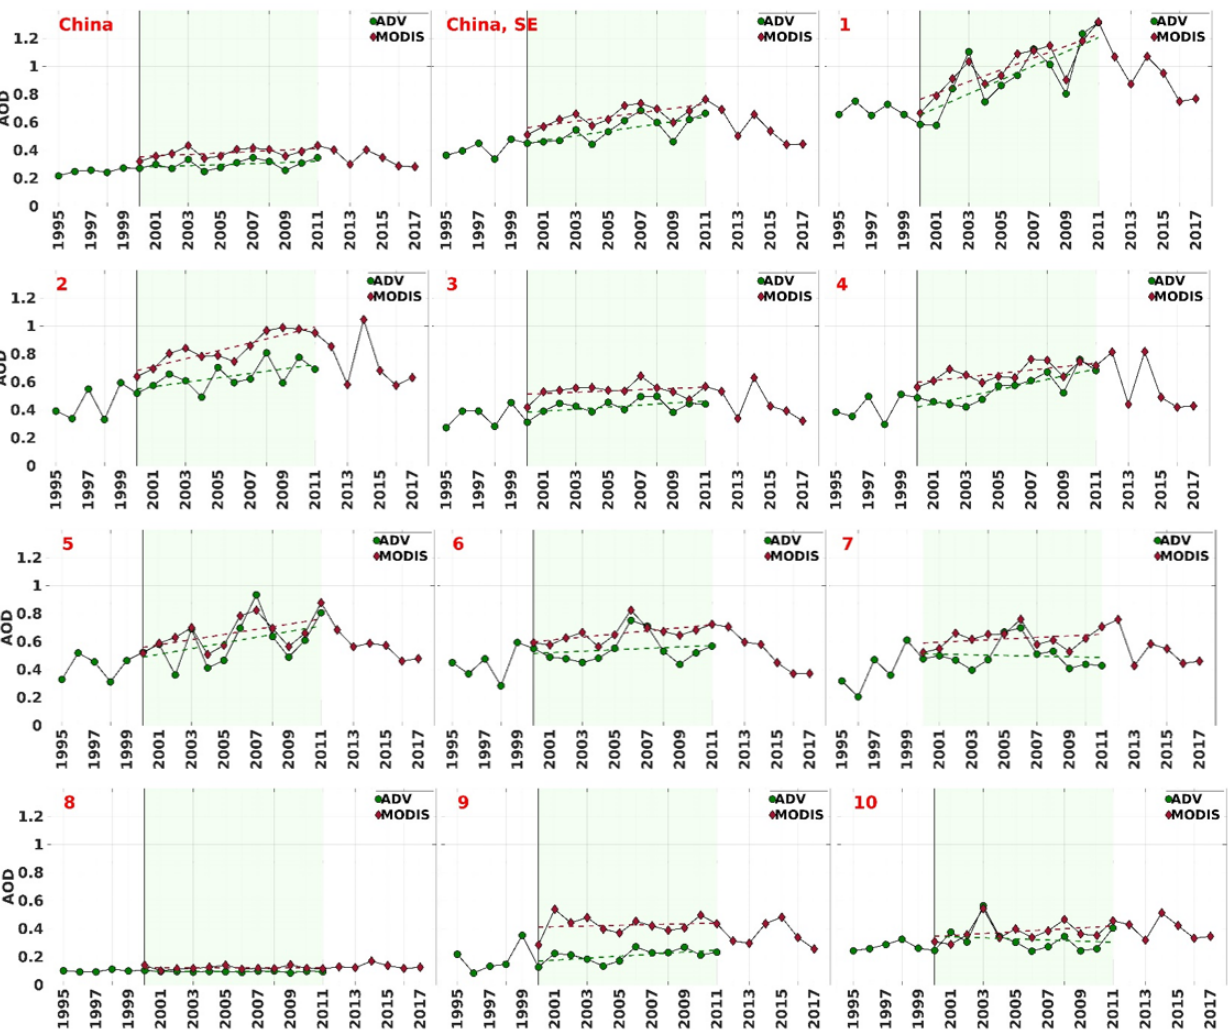
Figure 13. Time series of the summer-averaged AOD over China, SE China and each of the 10 selected regions, for ADV (1995–2011, green circles) and MODIS (2000–2017, red diamonds). The overlapping period is colored light green. AOD linear fits for the overlapping periods are shown for each instrument (green and red dashed lines for ADV and MODIS, respectively). Statistics for linear fits are shown in Table